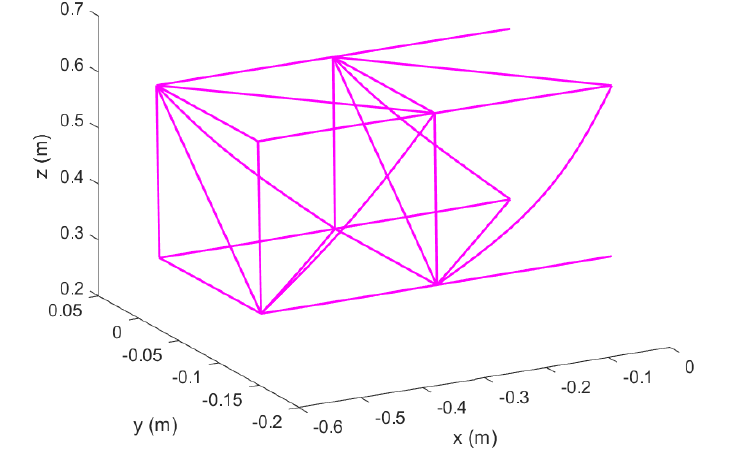
Figure 34. Mode 2 of Timoshenko beams in Topology 1 with hinged ends; spanwise expanded configuration.